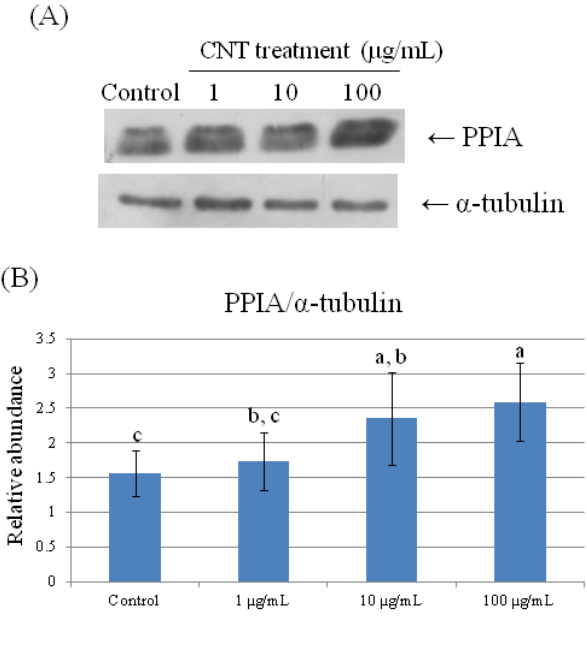
Figure 8. Validation of PPIA in CNT-treated chicken heterophils by Western Blot analysis. Samples were subjected to 12.5% SDS-PAGE. The protein in the polyacrylamide gel was transferred to a nitrocellulose membrane. ( A ) The immunoblot was produced by incubating the membrane with antibodies against PPIA and α -tubulin; ( B ) The relative abundance of PPIA/ α -tubulin was analyzed with Total Lab ® . Values are the mean ± SE of three batches. a–c The means with different superscripts differ significantly ( p <